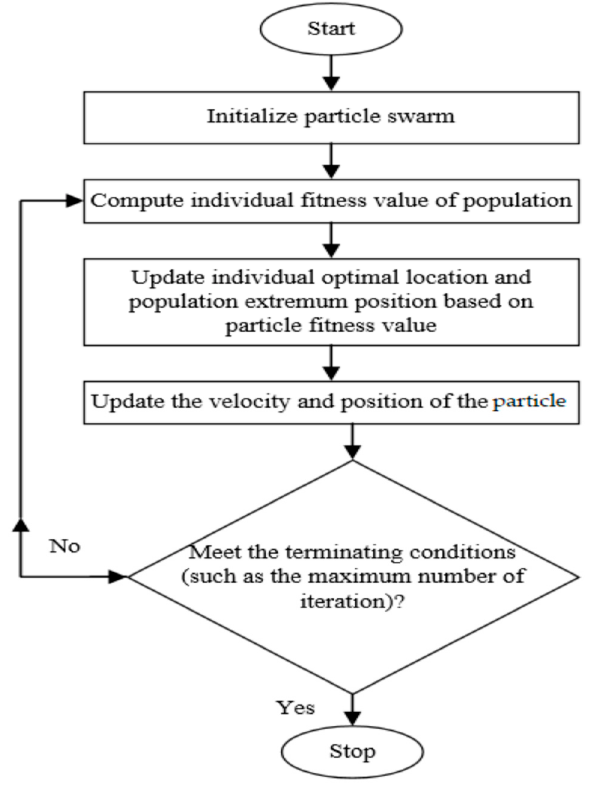
Figure 11. Flowchart of the standard PSO algorithm.